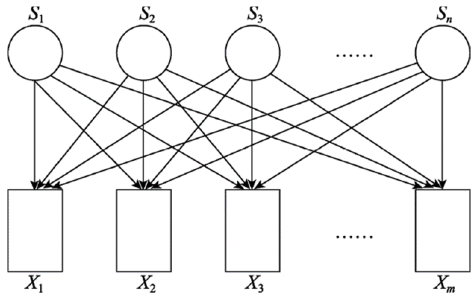
Figure 1. Diagram of a multi-source, multi-sensor testing procedure.